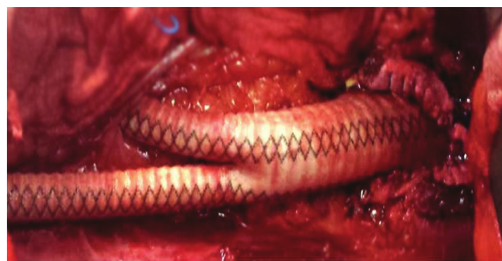
Figure 4: Supraceliac aortofemoral bypass performed through a retroperitoneal